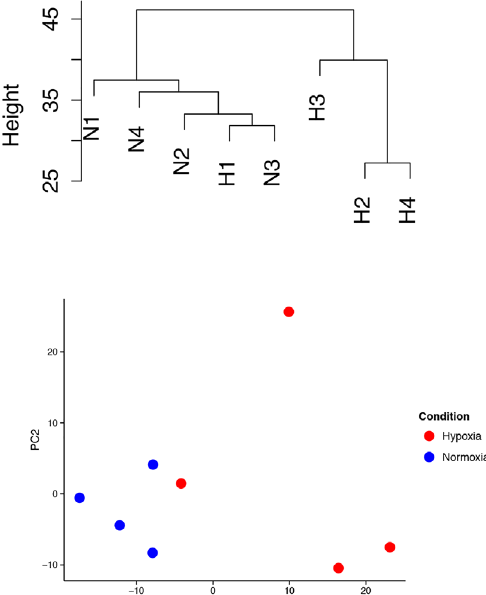
Fig 2. Hierarchical clustering. Top panel: Hierarchical clustering of gene expression in the normoxic (N1, N2, N3, and N4) and hypoxic (H1, H2, H3, H4) fetal pituitaries. Bottom panel: Principal component analysis of gene expression in normoxic (red symbols) and hypoxic (blue symbols) fetal pituitaries.